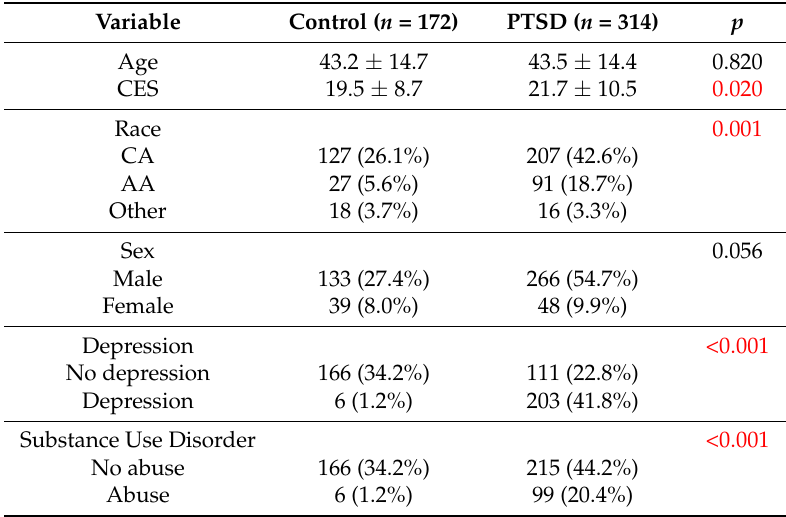
Table 1. Demographic and clinical characteristics of